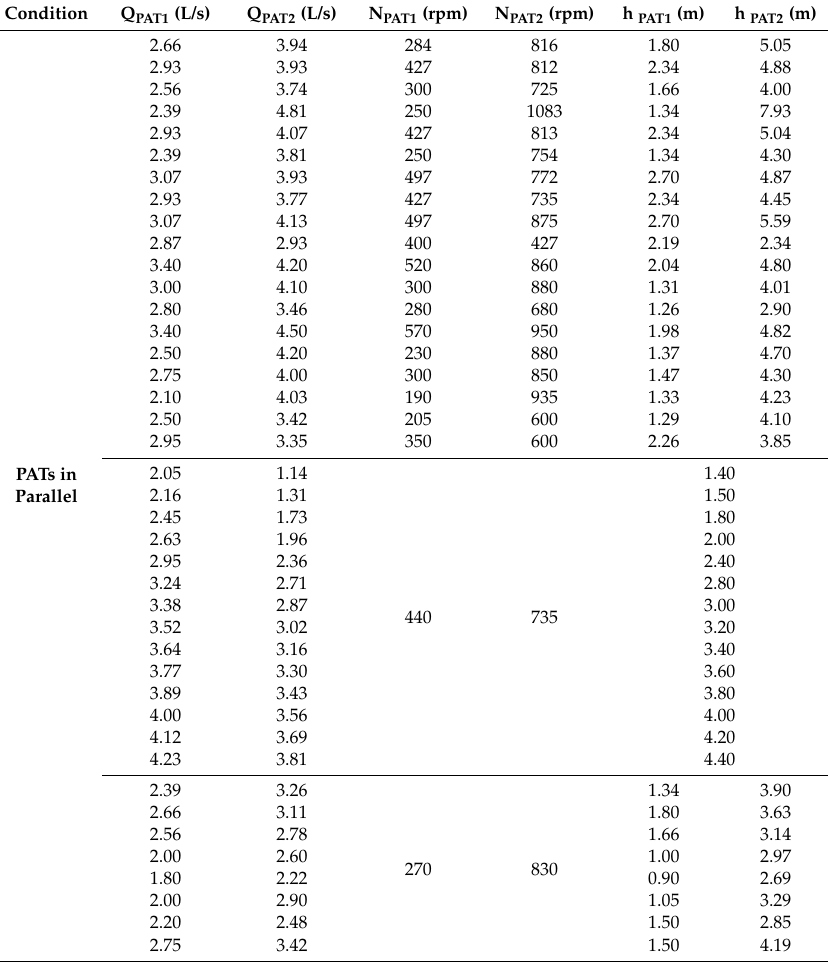
Table 1. Experimental tests. Q: discharge; N: rotational speed; h: net head.